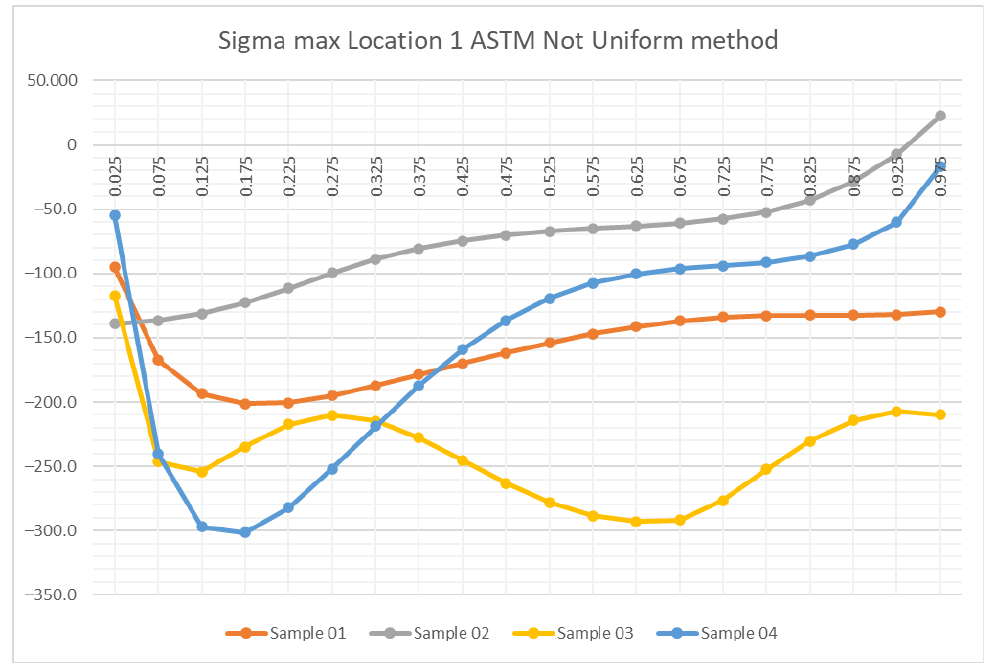
Figure 5. The resulting values of residual stresses (Sigma max) for all four samples at the measuring Location 1.